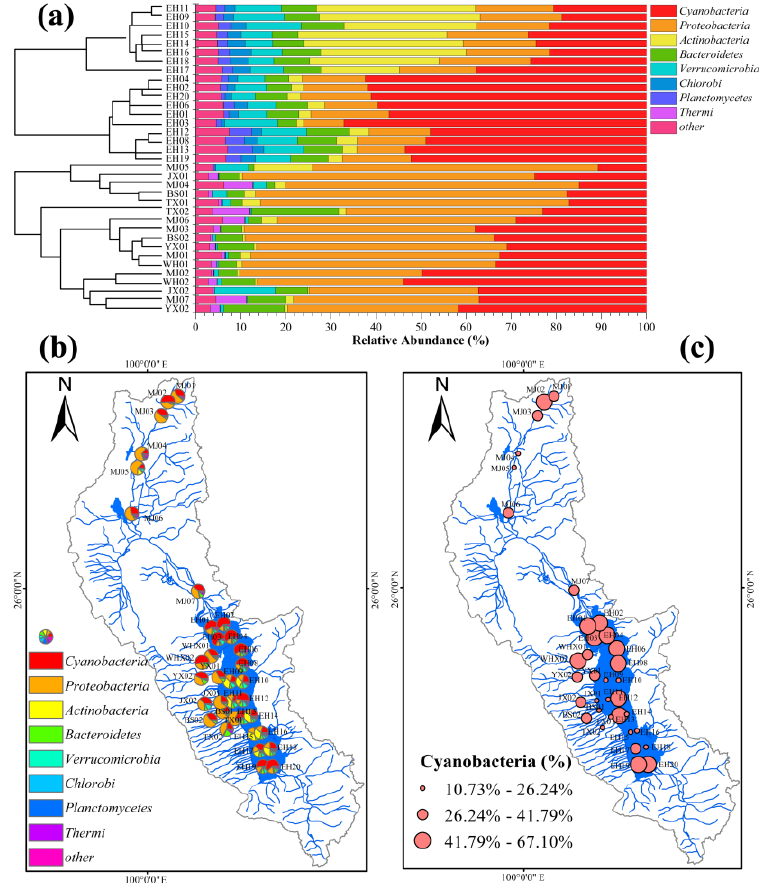
Figure 3. Composition of bacterial communities in Erhai Lake and streams ( a ) as well as the spatial variations in bacterial communities ( b ) and Cyanobacteria ( c ).